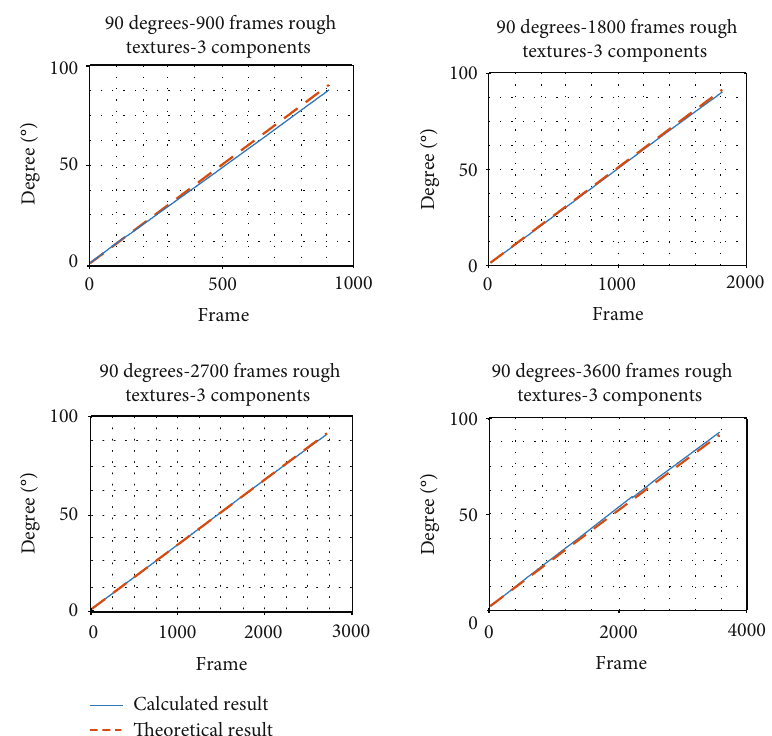
Figure 9: Angle estimation of model (b) under di ff erent imaging speeds (rotation angle of 90 degrees).